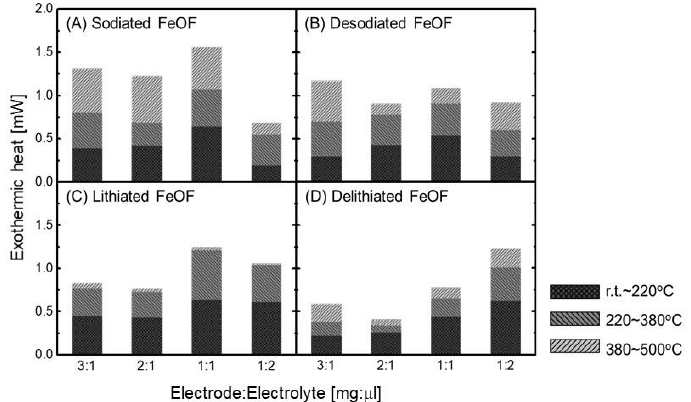
Figure 6. Quantitative comparison of the heat generation from the mixture of FeOF cathode and the associated electrolyte for Li- and Na-ion batteries.